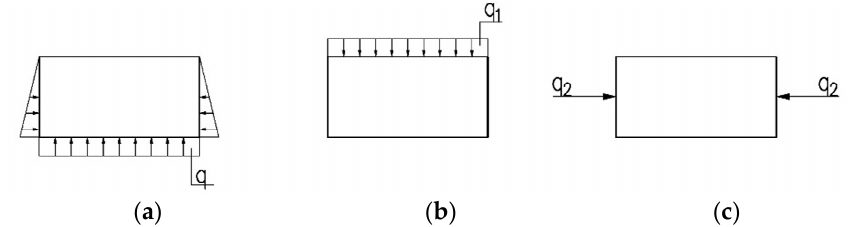
Figure 3. Schematic drawing of the hydrostatic load acting on the tank walls and the bottom ( a ), uniform load acting on the upper plate ( b ) and ice floe pressure ( c ), for which static calculations were made.